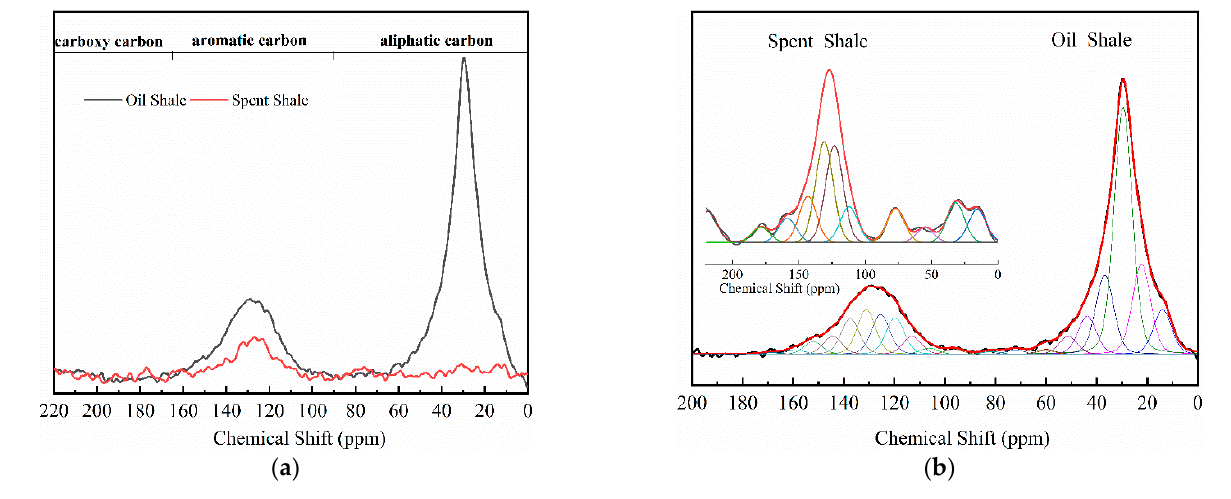
Figure 1. Solid-state 13 C NMR spectra ( a ) and fitted curves ( b ) of Jimsar oil shale and its spent shale, obtained at a heating rate of 5 o C/min.